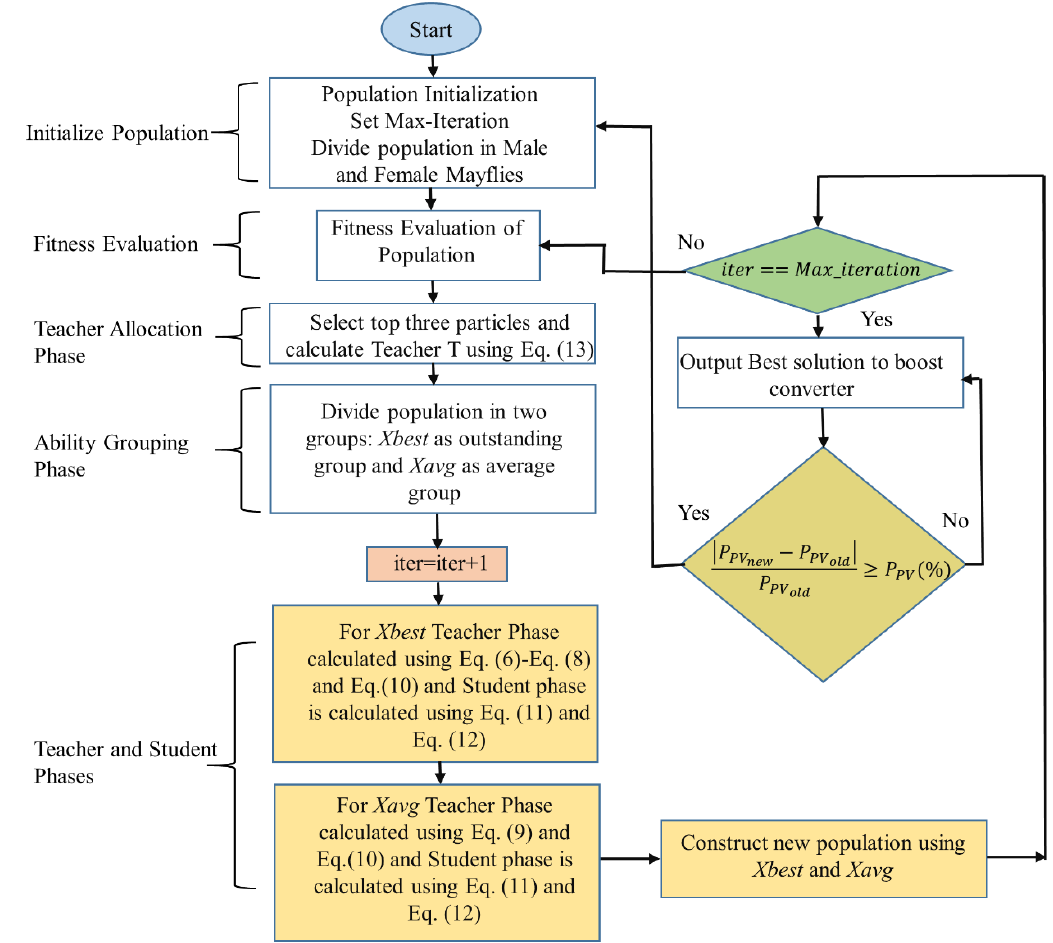
Figure 8. Working of GTOA as MPPT under PS conditions.